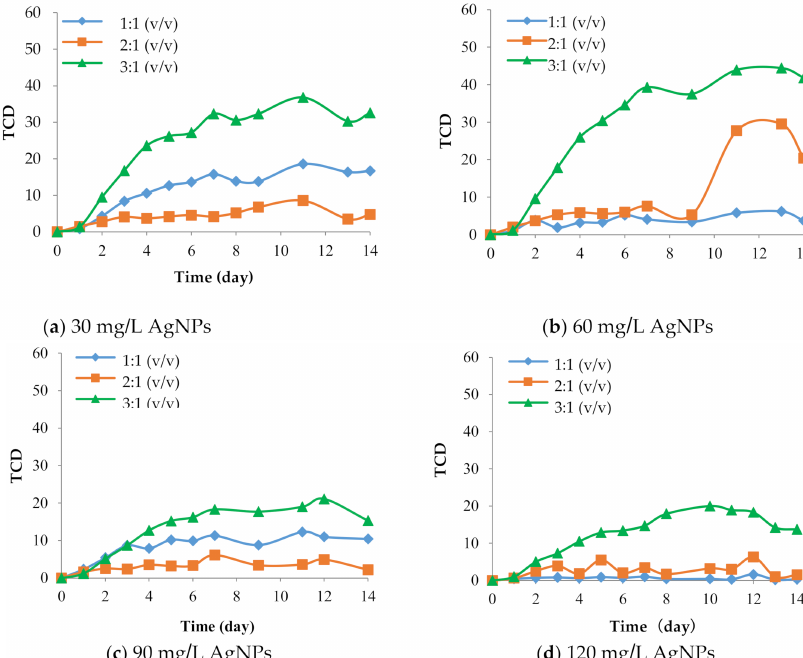
Figure 1. E ff ect of carboxymethyl cellulose:polydiacetylene / silver nanoparticle (CMC:PDA / AgNP) ratios—3:1 (green line), 2:1 (orange line), and 1:1 (blue line)—on changes in total color di ff erence (TCD) of films at 35 ◦ C with ( a ) 30 mg / L, ( b ) 60 mg / L, ( c ) 90 mg / L, and ( d ) 120 mg / L AgNP